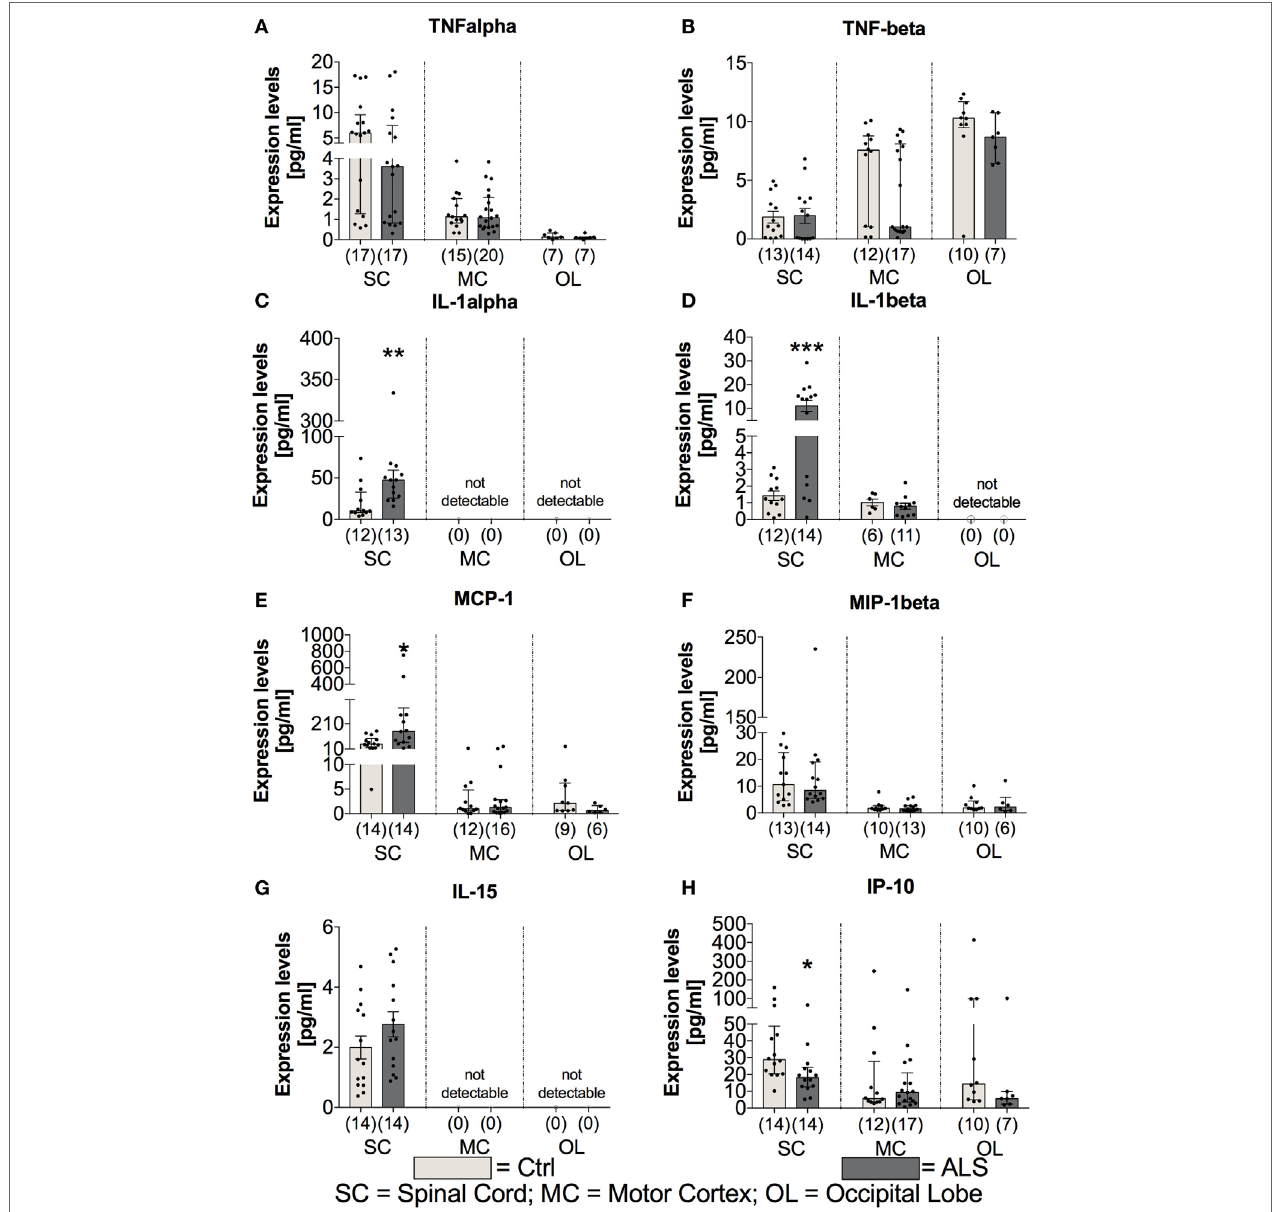
FigUre 7 | Tissue concentrations of proinflammatory cytokines and chemokines. Expression levels of proinflammatory cytokines where either unchanged [TNF α (a) , TNF β (b) , significantly enhanced (IL­1 α (c) , IL­1 β (D) ), IL­15 (g)] , or significantly reduced [IP­10, (h) ] in amyotrophic lateral sclerosis (ALS) patients compared to healthy controls (Ctrl). The expression of the proinflammatory chemokine MCP­1 (e) was significantly increased, whereas the amounts of MIP­1 β (F) were unaffected. Effects were only detectable within the spinal cord (SC). For the motor cortex (MC) and the occipital lobe (OL), the expression levels were unchanged within the two groups or not detectable. * p < 0.05 vs. Ctrl, ** p < 0.01 vs. Ctrl, *** p < 0.001 vs. Ctrl. Numbers of patients are given in brackets; All parameters were tested for Gaussian distribution using D’Augostino­Pearson omnibus normality test. Two­tailed Mann–Whitney test for TNF α , TNF β (MC, OL), IL­1 α , MCP­1, MIP­1 β , IP­10, data represent median with interquartile range; two­tailed unpaired Student’s t ­test for TNF β (SC), IL­1 β , and IL­15, data represent mean ±